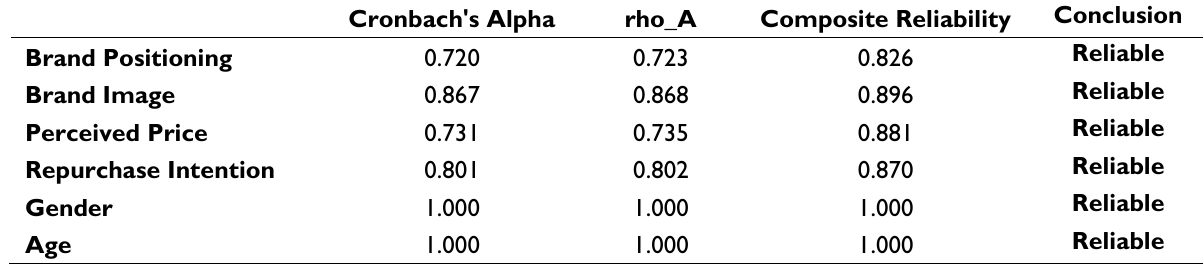
Table 5. Discriminant Reliability Test